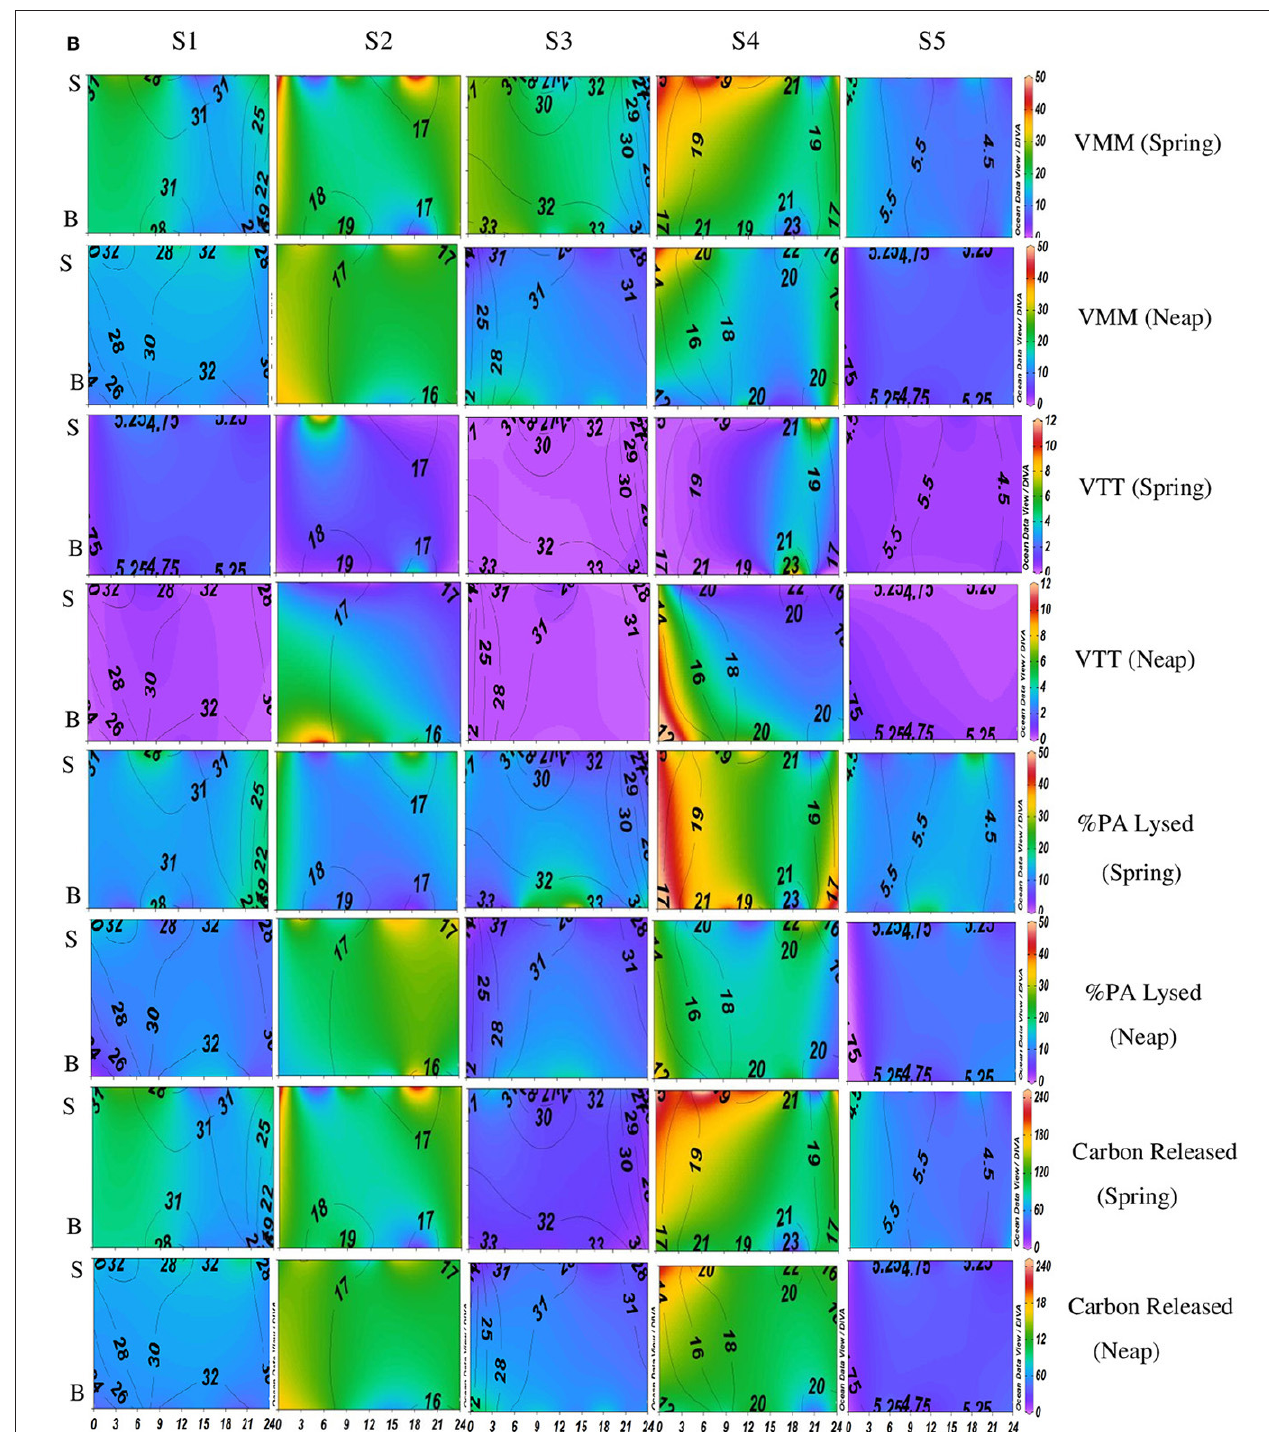
FIGURE 3B | Temporal variations (diel and tidal) in biological parameters during pre-monsoon (PRM) in CE. X-axis represents the time series observations from 00:00 to 24:00 h and Y-axis represent the vertical section of the water column (S, Surface; B, Bottom). Z-axis represent different parameters in color contours and salinity is superimposed as the line contours. The vertical panels S1, S2, S3, S4, and S5 represents the five stations. The horizontal panels represent various parameters during PRM, such as, Viral-mediated mortality (VMM%), Viral turnover time (VTT) (d − 1 ), % of BA lysed, and Carbon released ( µ g/C/L/day) during spring and neap phases